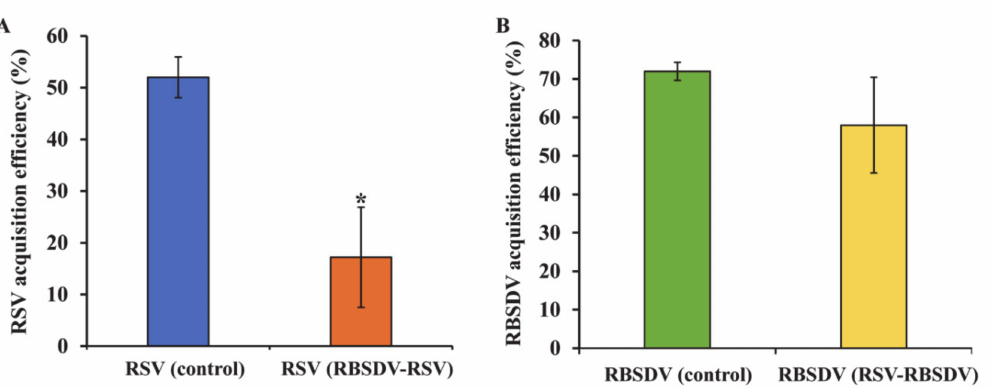
Figure 1. Virus acquisition efficiency after access of SBPH insect vector to RBSDV and RSV in different orders. Acquisition efficiency of ( A ) RSV after access to RBSDV first, then to RSV (RBSDV-RSV); ( B ) RBSDV after access to RSV first, then to RBSDV (RSV-RBSDV). The presence of viruses in individual insects was determined by RT-PCR using RSV- and RBSDV- specific primers. Asterisk (*) indicates a significant difference in efficiency of RSV acquisition between RSV-only control and RBSDV-RSV groups; p < 0.05 according to Tukey’s HSD test with 95% confidence.